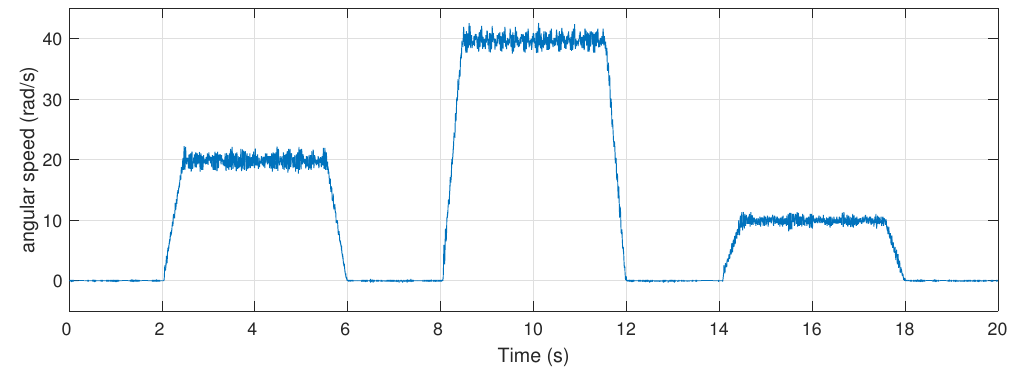
Figure 10. Experimental result: motor angular speed ω under the PI controller and proposed